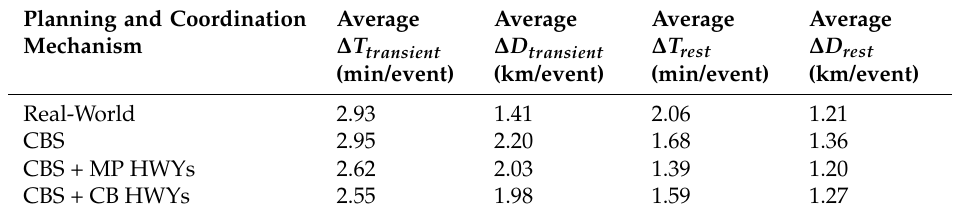
Table 4. MAS simulation average responses for the runway reconfiguration events on 2 May